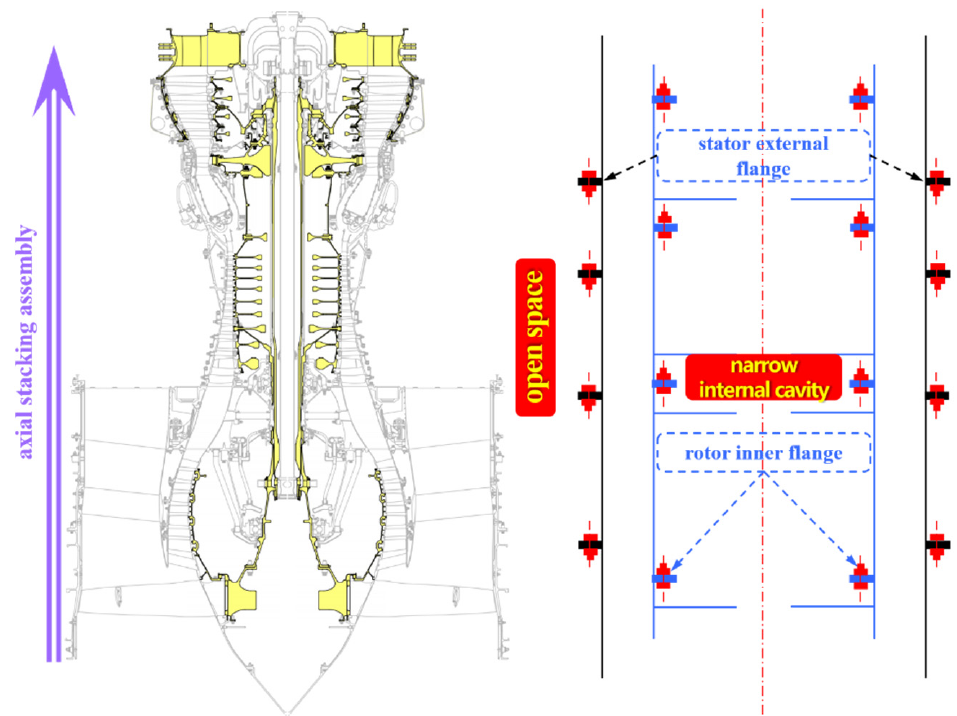
Figure 16. Schematic diagram of an aeroengine stator–rotor substructure system’s tightening space.